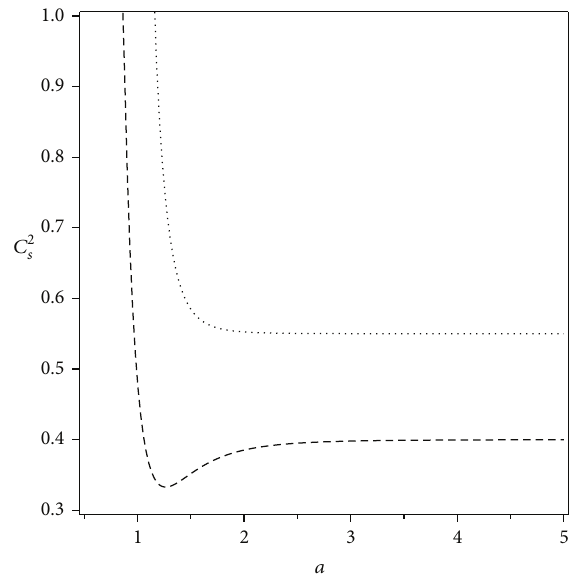
Figure 18: Squared sound speed for 𝐵 = 0.5 , 𝛼 = 0.5 , and 𝐴 = 0.05 . 𝑛 = 2 (dashed line), 𝑛 = 3 (dotted